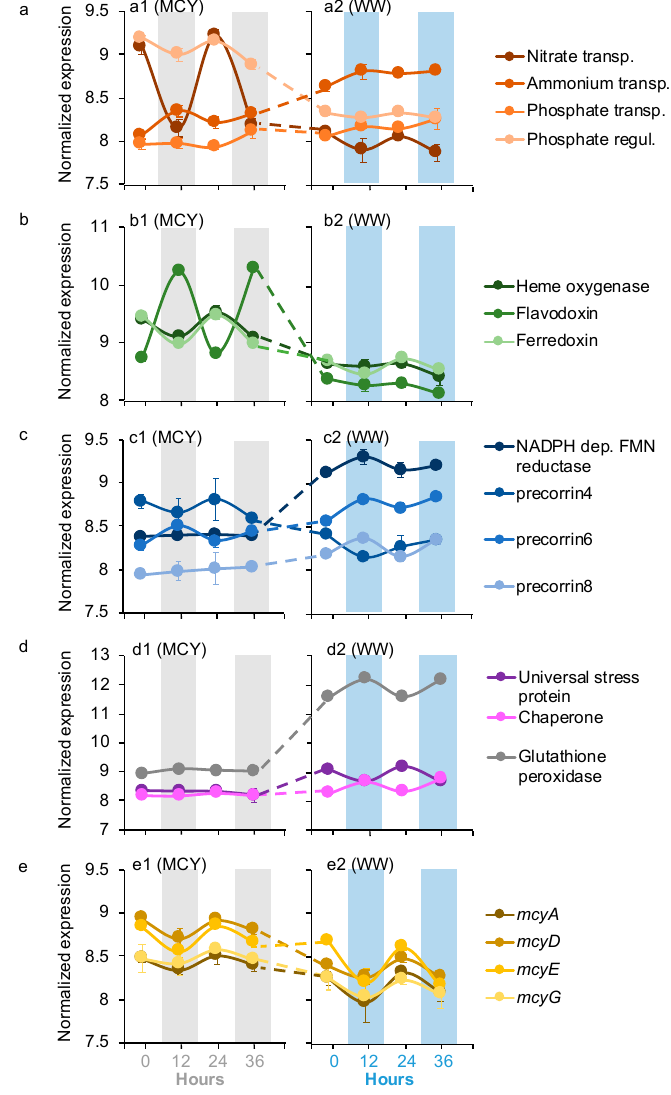
Figure 2. Averages of normalized Microcystis gene expression values based on variance stabilizing transformation in DeSeq2 related to ( a ) nitrogen and phosphorus metabolism, ( b ) iron metabolism, ( c ) vitamin biosynthesis, ( d ) stress response and H 2 O 2 depletion, and ( e ) microcystin synthesis. Gray bars and blue bars indicate dark conditions samples in the MCY and WW, respectively. The error bar represents standard error of the gene expression values.